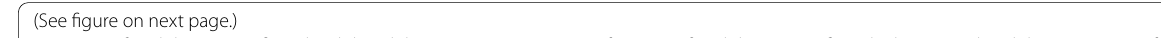
factor-κB(See figure on next Fig. 4 PKCβ 1 inhibitors significantly inhibited the immune maturation of DCs. PKCβ 1 inhibitors significantly down-regulated the expression of CD83 and CD86 in BMDCs, as well as the inflammatory cytokines, TNFα and IFNγ, tested by ELISA. However, PKCα inhibitors and PKCβ 2 inhibitors did not have similar effects ( a , b , *p < 0.05 vs. oxLDL AGEs group). PMA, a PKC agonist, up-regulated the expression of CD83 and CD86 in BMDCs + and promoted the secretion of the inflammatory cytokines, TNFα and IFNγ, while PKCβ 1 inhibitors inhibited these effects ( c , d , *p < 0.05 vs. control group; # p < 0.05 vs. PMA group). PKCβ 1 inhibitors inhibited the PMA and oxLDL plus AGEs-induced activation of the NF-κB signaling pathway ( e , f , − *p < 0.05 vs. oxLDL AGEs group). Values, mean SED; n 3, oxLDL oxidized low density lipoprotein, AGEs advanced glycation end-products, PKC + ± = protein kinase C, IFNγ IFN gamma, TNFα Tumor necrosis factor alpha, PMA phorbol ester, NF-κB nuclear